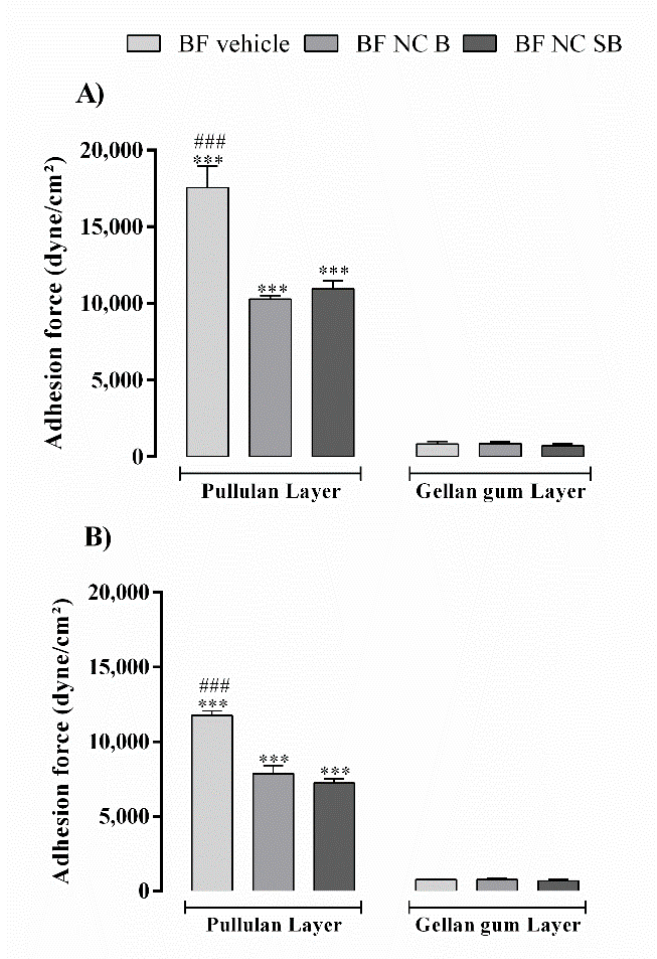
Figure 2. In vitro bioadhesion evaluation using the non-injured ( A ) and injured ( B ) skin of bilayer vehicle film (BF vehicle) and films containing nanocapsules with silibinin (BF NC SB) or without (BF NC B). Each column represents the mean ± SD. The films were evaluated on both sides (pullulan layer and gellan gum layer). (***) p < 0.001 significant differences between pullulan layer and gellan gum layer, (###) p < 0.001 significant differences between BF vehicle and BF NC SB or BF NC B (Two-way ANOVA followed by Tukey’s test).